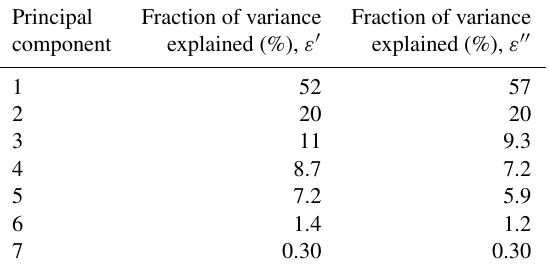
Table 5. Results from principal component analysis. Variance asso- ciated with each principal component for ε (cid:48) and ε (cid:48)(cid:48) .